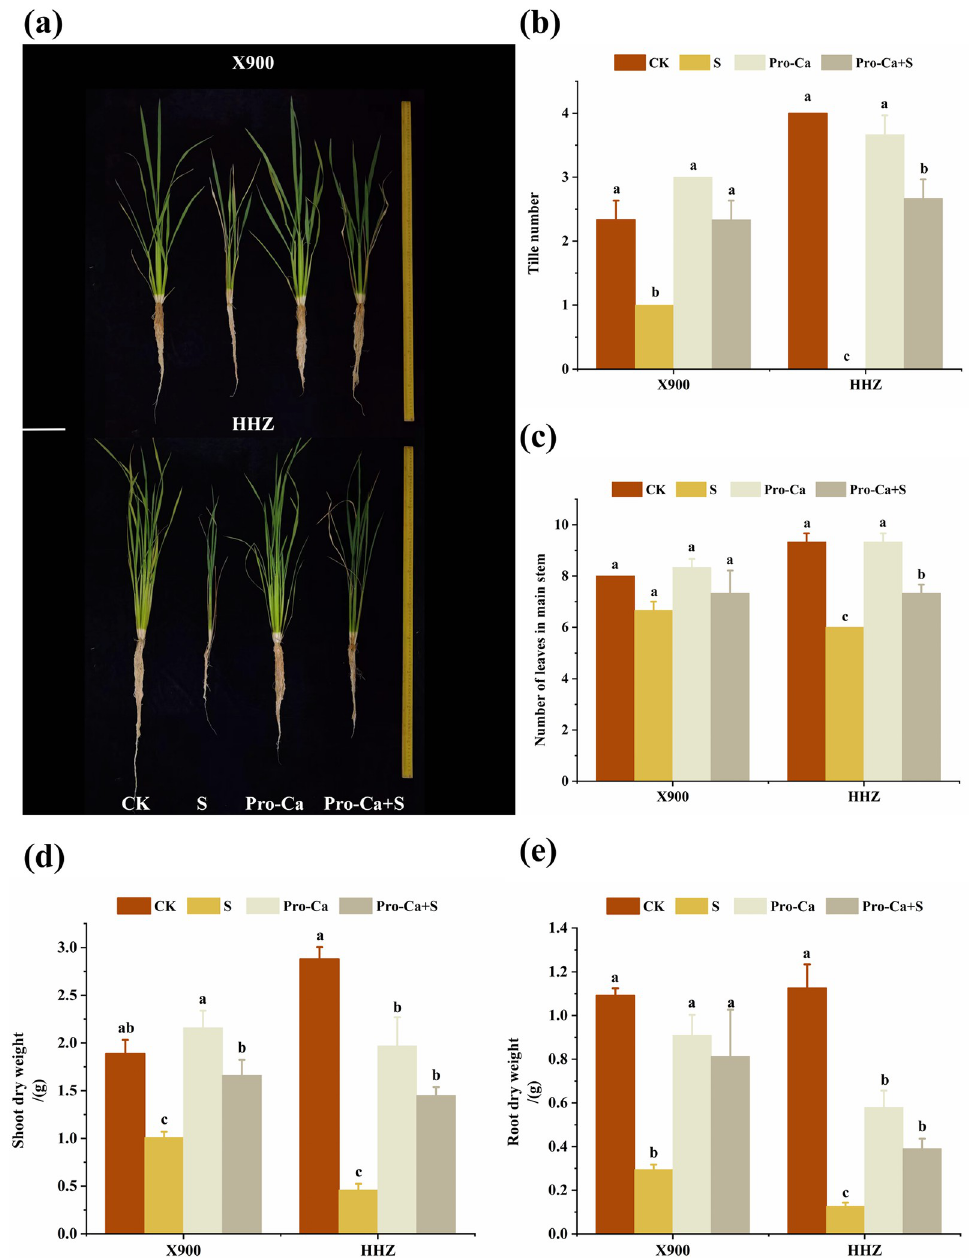
Fig 1. Alleviating effect of exogenous prohexadione-calcium (Pro-Ca) on tillering ability of rice under salt stress. The morphology (a), tiller number (b), number of leaves in the main stem (c), and shoot and root dry weight (d and e) of the X900 and HHZ varieties under different treatments. Abbreviations: CK (water spraying + 0% NaCl), S (water spraying + 0.3% NaCl), Pro-Ca (100 mg � L -1 Pro-Ca leaf spraying + 0.3% NaCl), and Pro-Ca + S (100 mg � L -1 Pro-Ca leaf spraying + 0.3% NaCl). The numerical value represents the mean ± SE ( n = 3), and different lowercase letters indicate significant differences according to Duncan’s test ( p <